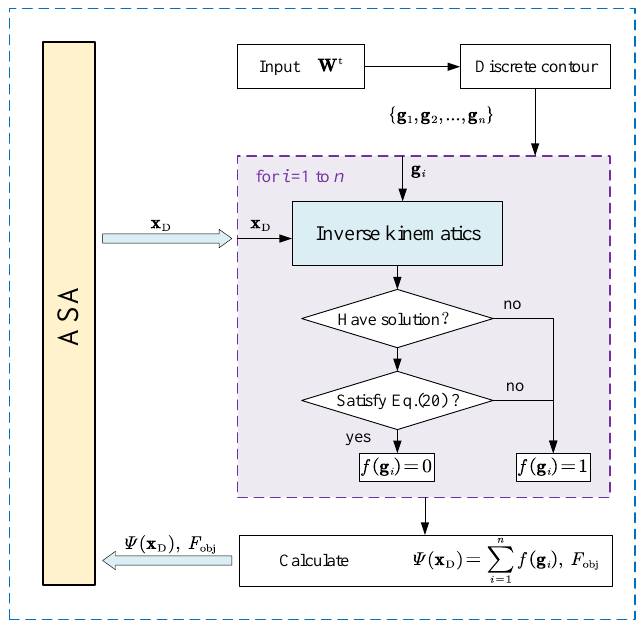
Figure 6. Optimization